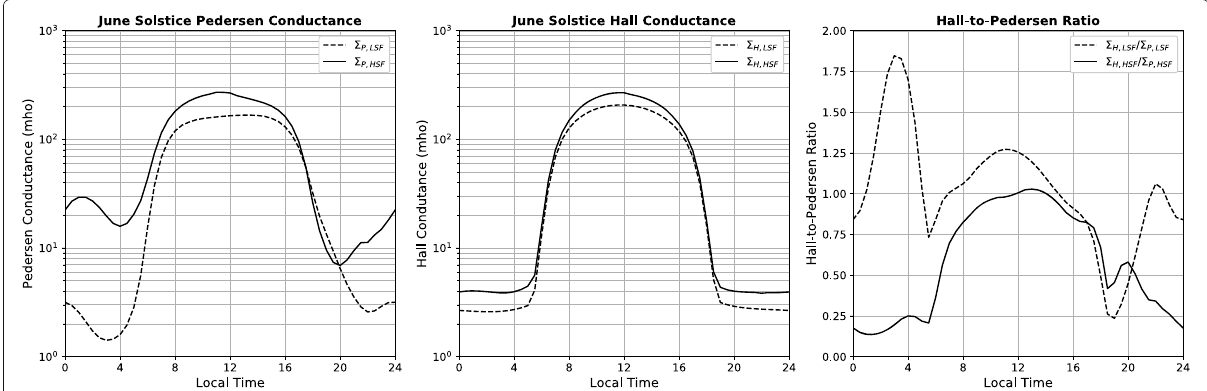
Fig. 8 Comparison of the local time dependence of the Pedersen conductance (left), Hall conductance (middle), and Hall-to-Pedersen ratio (right) during June solstice at an apex height of 240 km. The solid (dashed) lines correspond to HSF (LSF) conditions